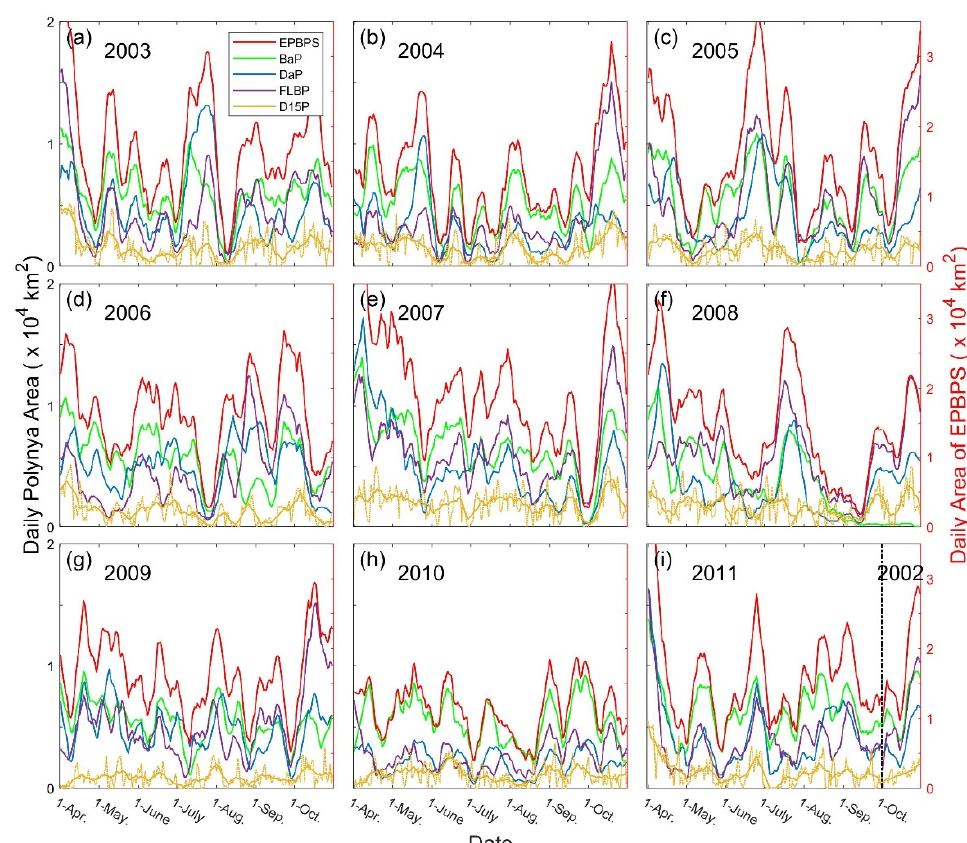
Figure 3. ( a – i ) Daily areas of the four polynyas and the entire polynya system (EPBPS) in eastern Prydz Bay. The solid lines indicate the 10-day running mean, and the dashed yellow lines indicate the original data for the D15P. Note: the left vertical axis is the daily area of the four polynyas, and the right vertical axis is the daily area of the EPBPS.